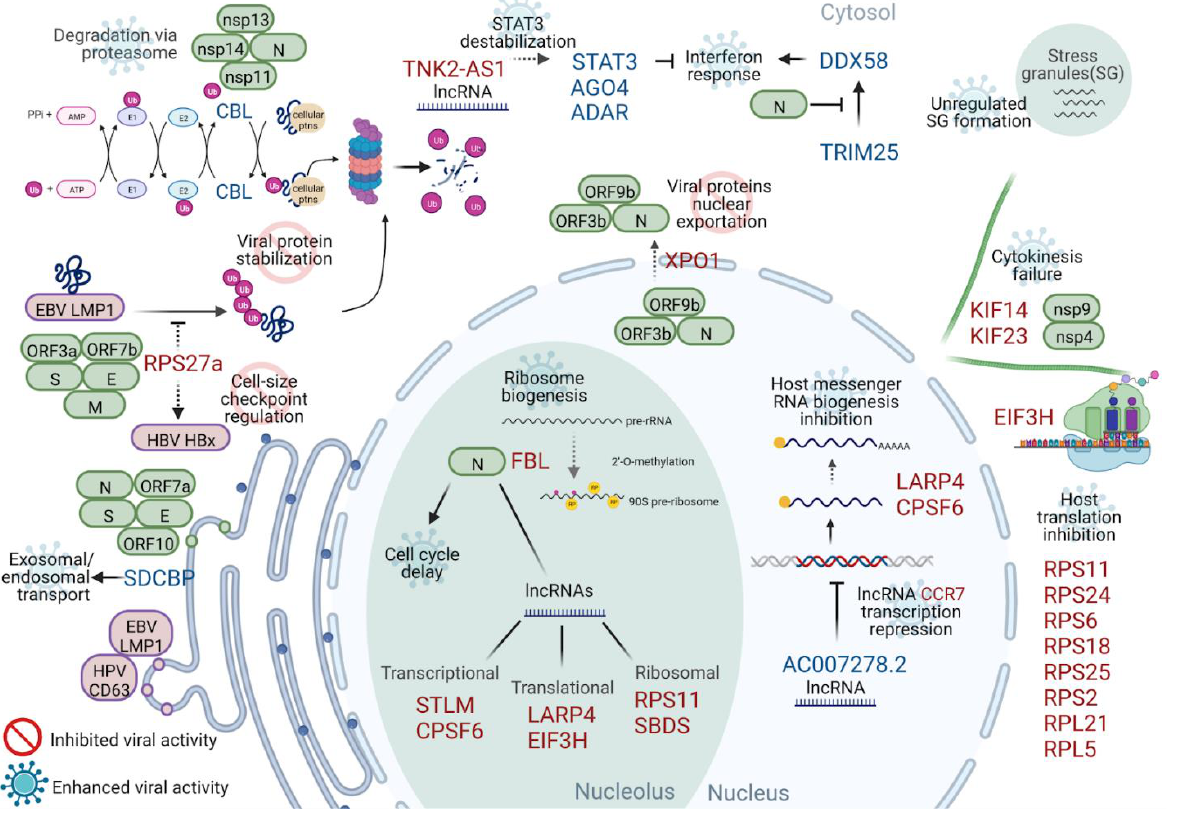
Figure 6. Schematic of the putative impact of DEGs on viral activity. The most-connected genes or those that participate in the main enriched pathways are placed together with SARS-CoV-2 and other virus proteins that interact with each. The host protein functions and their possible role in the cell response to the virus or inhibition due to viral infection were inferred based on the literature. Ribosome biogenesis (also through long non-coding RNA branching), cell cycle delay, and host translation inhibition are the processes more concentrated in differentially expressed genes. SARS- CoV-2 proteins are shown in green boxes; other viral proteins are shown in purple boxes. For differentially expressed genes, up-regulated genes are marked in red, while down-regulated genes are marked in blue. The pathways are shown in black, each marked with a "prohibited" icon for inhibited viral activity or a "virus" icon for enhanced viral activity. The acronym SG denotes stress granules. Created with BioRender.com.